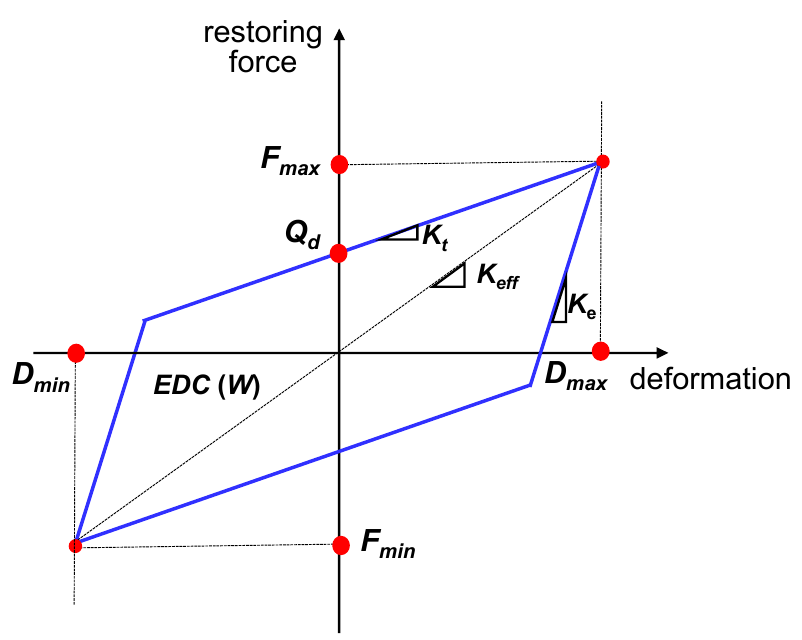
Figure 2. Concept of bilinear model of LRB.